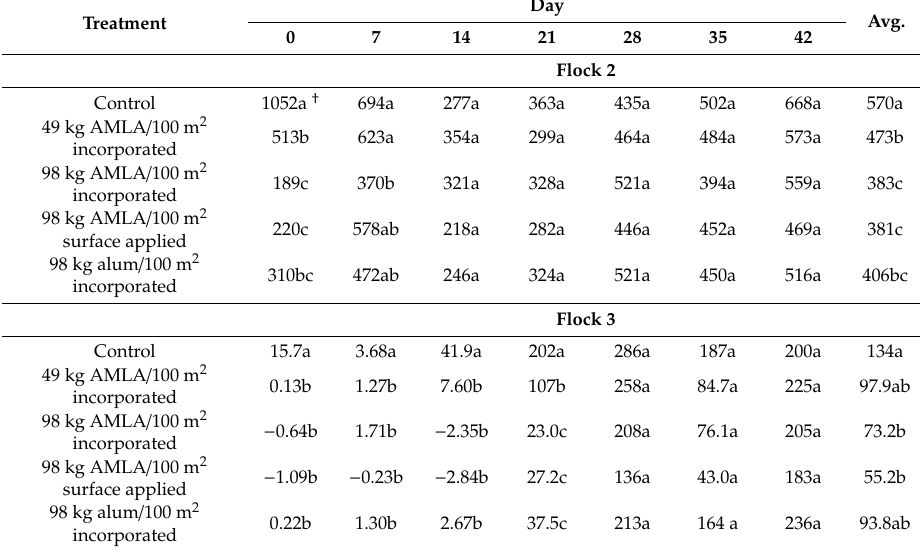
Table 5. Average ammonia flux (mg NH 3 -N m − 2 hr − 1 ) for flock 2 and 3 by treatment by day.